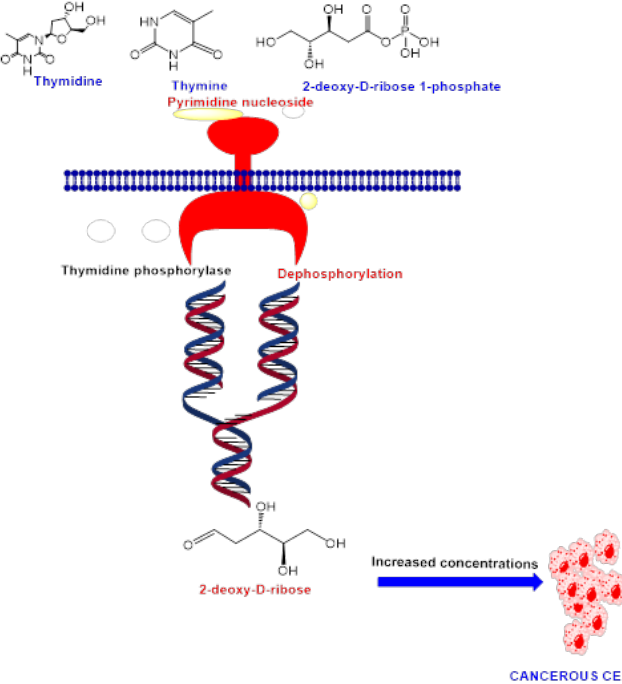
Figure 21. The 2-((2-(2-methyl-5-nitro-1H-imidazol-1-yl)ethyl)thio)-5-(2-nitrophenyl)-1,3,4-oxadia- zoleas thymidylate synthase inhibitor .